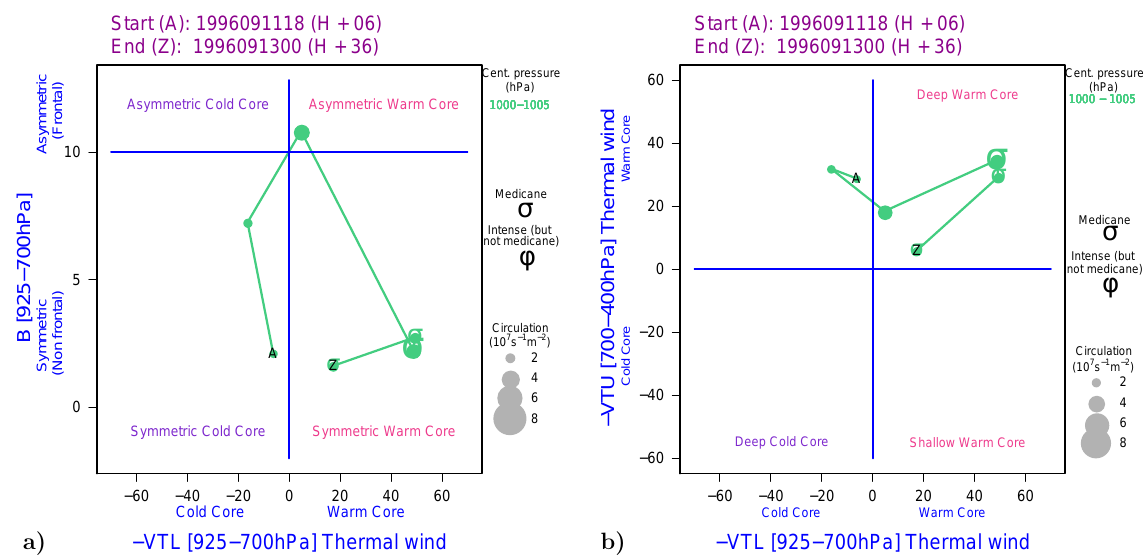
Fig. 10. Cyclone phase diagrams I and II medicane (a, b) , as Fig. 3, for September 1996